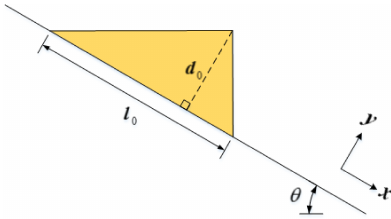
Figure 3. Definition sketch for initial conditions of an avalanche along a